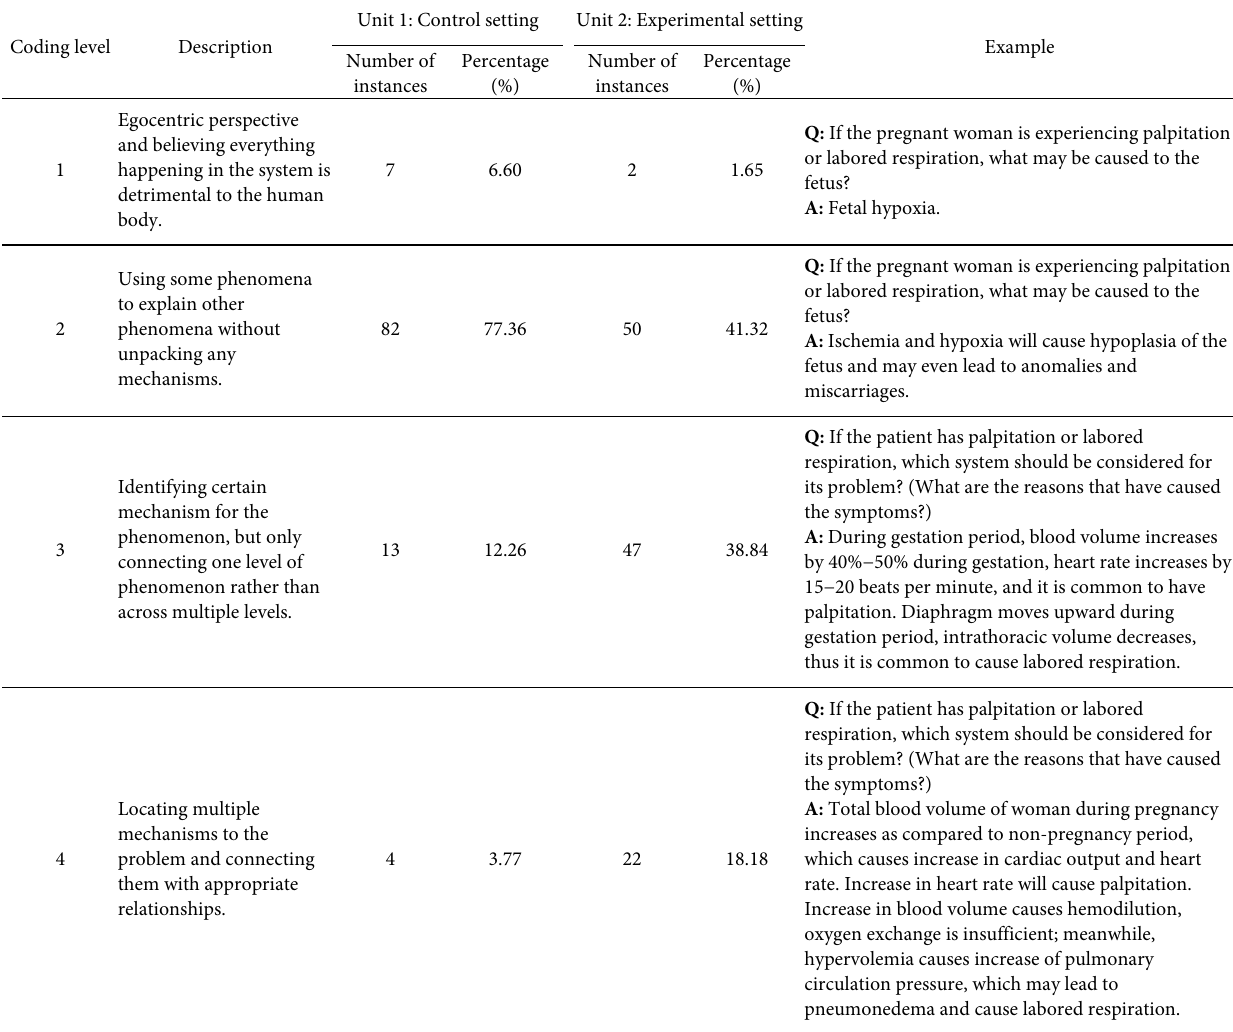
Table 3 Coding schemes of systems thinking and examples of students ’ answers.